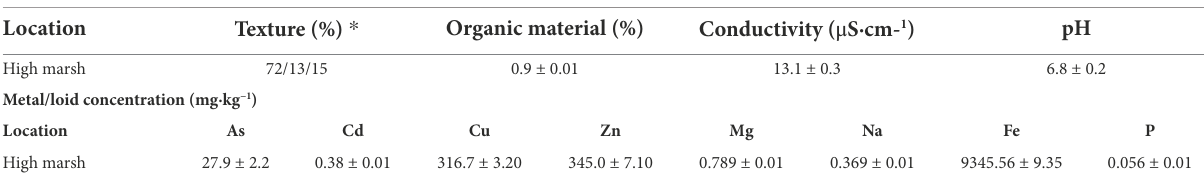
TABLE 1 Physicochemical properties and micronutrients concentrations of soil from high marshes of the Odiel